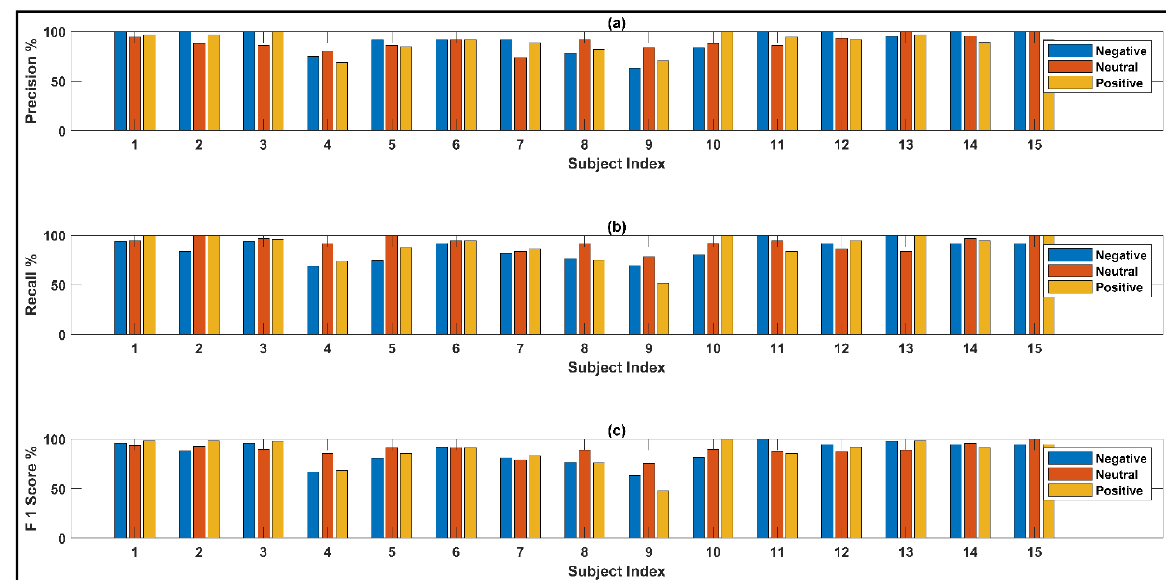
Figure 15. Observed ( a ) precision ( b ) recall and ( c ) F1 scores from the network excluding the corrupt channels.